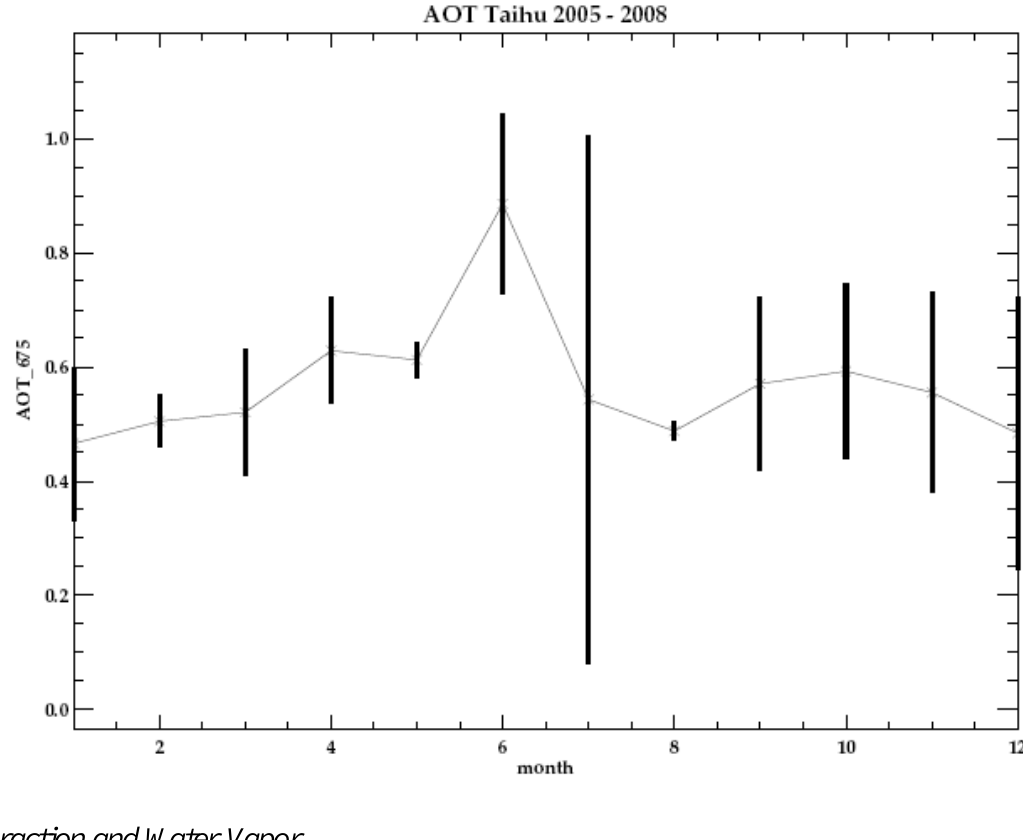
Figure 11. Averaged monthly aerosol optical thickness (AOT) obtained from AERONET from 2005 to 2008, where black solid bar represents 95% confidence interval